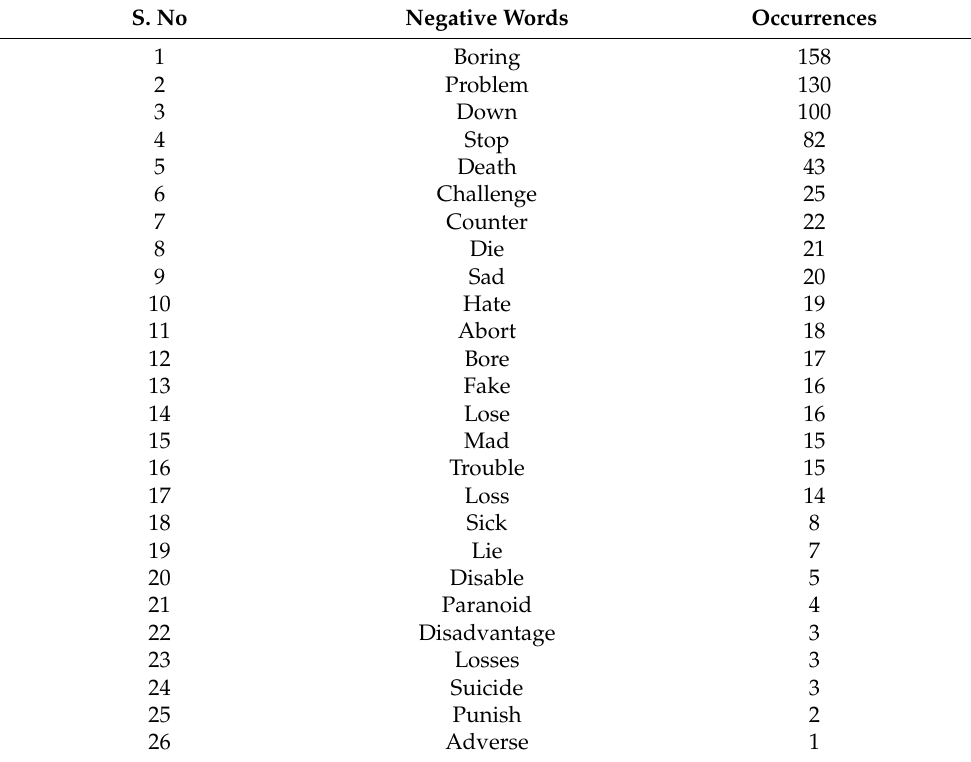
Figure 2. Transformed data representing all the five variables. We found a leptokurtic (heavy-tailed distribution) trail in all out variables, however, with varying degrees. The negative sentiment (Ngsnt) was significantly leptokurtic com- pared to others (see Table 2). This seems rather logical, though. Bond is second in the list (referring to Kurtosis), having a substantially higher skewed nature over the rest. The presence of fat-tails or heavy tails in all the variables under consideration proves signifi- cant deviation from EMH due to behavioral traces (represented by Ngsnt). The station- arity of the variables has been proved by ERS test (Elliot et al. 1996). Table 2. Descriptive statistics of all five variables. Ngsnt